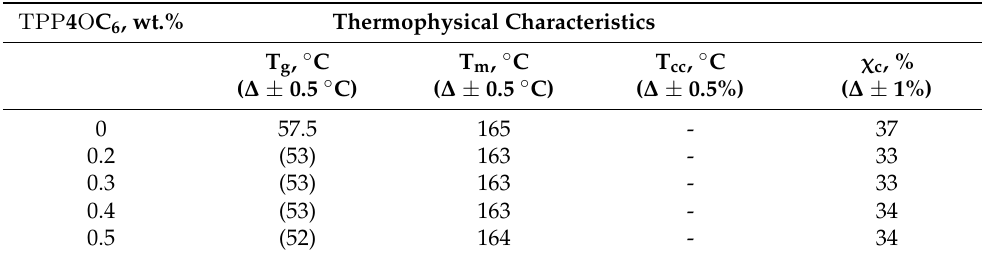
Figure 5. Temperature dependence of the crystallization rate (a theoretical curve). Table 1. Thermophysical characteristics of PLA- ТРР 4 О C6 composites. ТРР 4 О C 6 ,